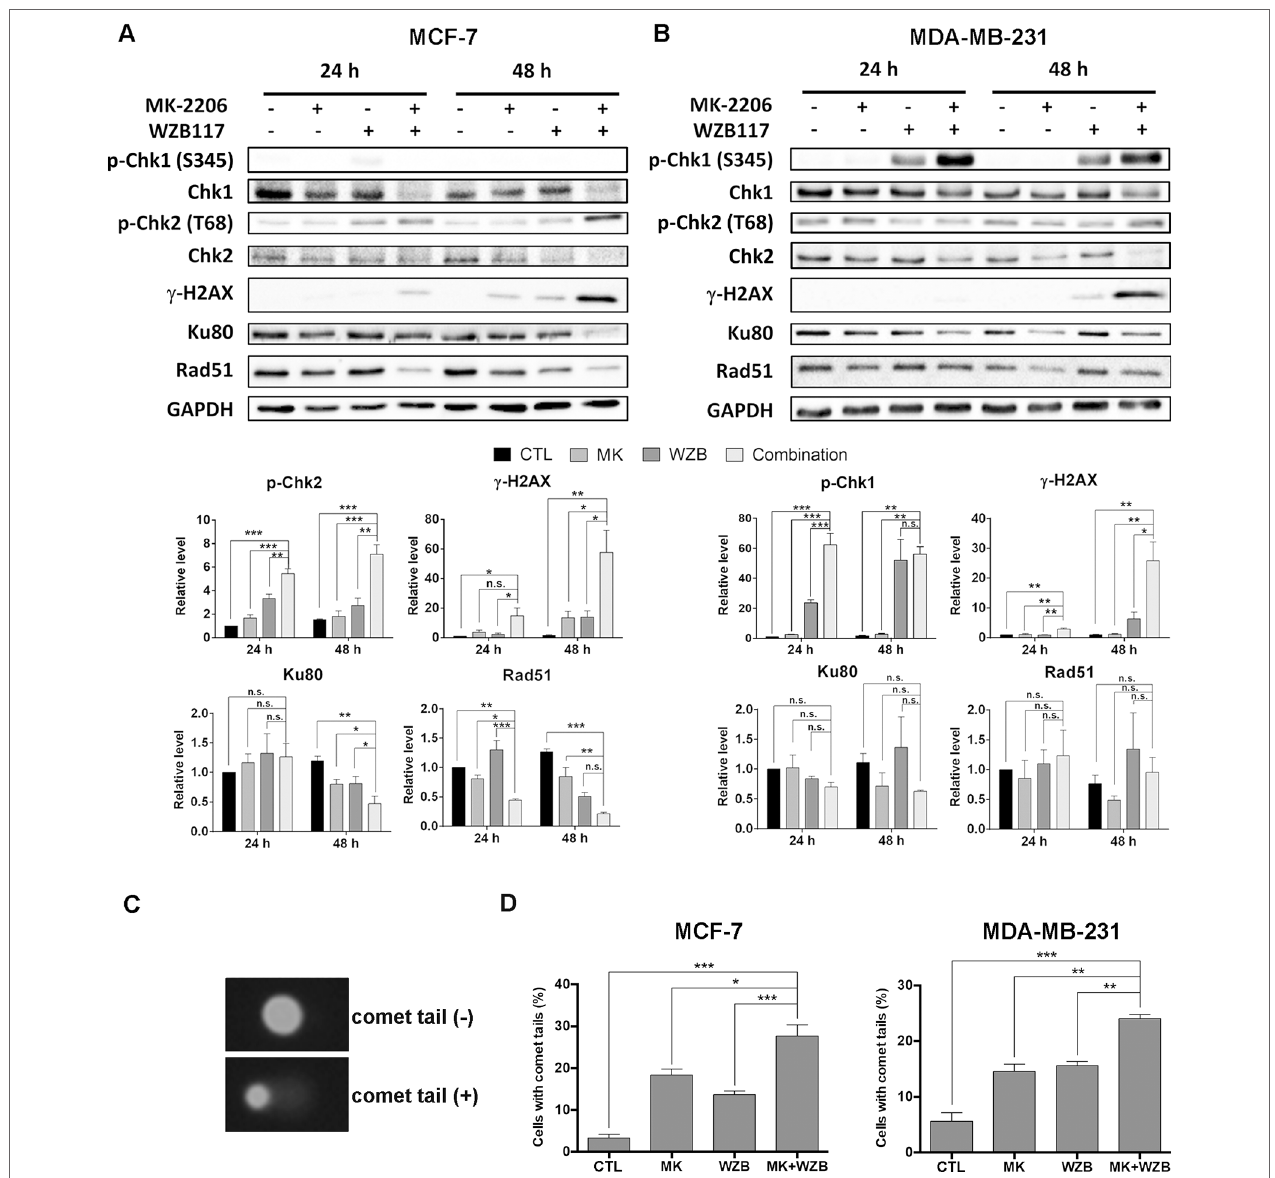
FIGURE 5 | MK-2206 and WZB117 affect proteins involved in DNA damage signaling and repair, determined by Western blot analysis, and induce DNA damage, determined by the comet assay. (A) MCF-7 cells. (B) MDA-MB-231 cells. MCF-7 cells were treated with 6 μM MK-2206 and 60 μM WZB117 and MDA-MB-231 cells were treated with 12 μM MK-2206 and 60 μM WZB117, either alone or in combination, for 24 or 48 h. Cells were then harvested for Western blot analysis. Quantitative data are presented as the mean ± SEM of three independent experiments. (C) Comet images. (D) Quantitative data of comet assay. MCF-7 cells were treated with 6 μM MK-2206 and/or 60 μM WZB117 for 1 h and MDA-MB-231 cells were treated with 12 μM MK-2206 and/or 60 μM WZB117 for 6 h and subjected to alkaline comet assay. Data are presented as the mean ± SEM of three independent experiments. *P < 0.05; **P < 0.01; ***P < 0.001; n.s., not significant (P >